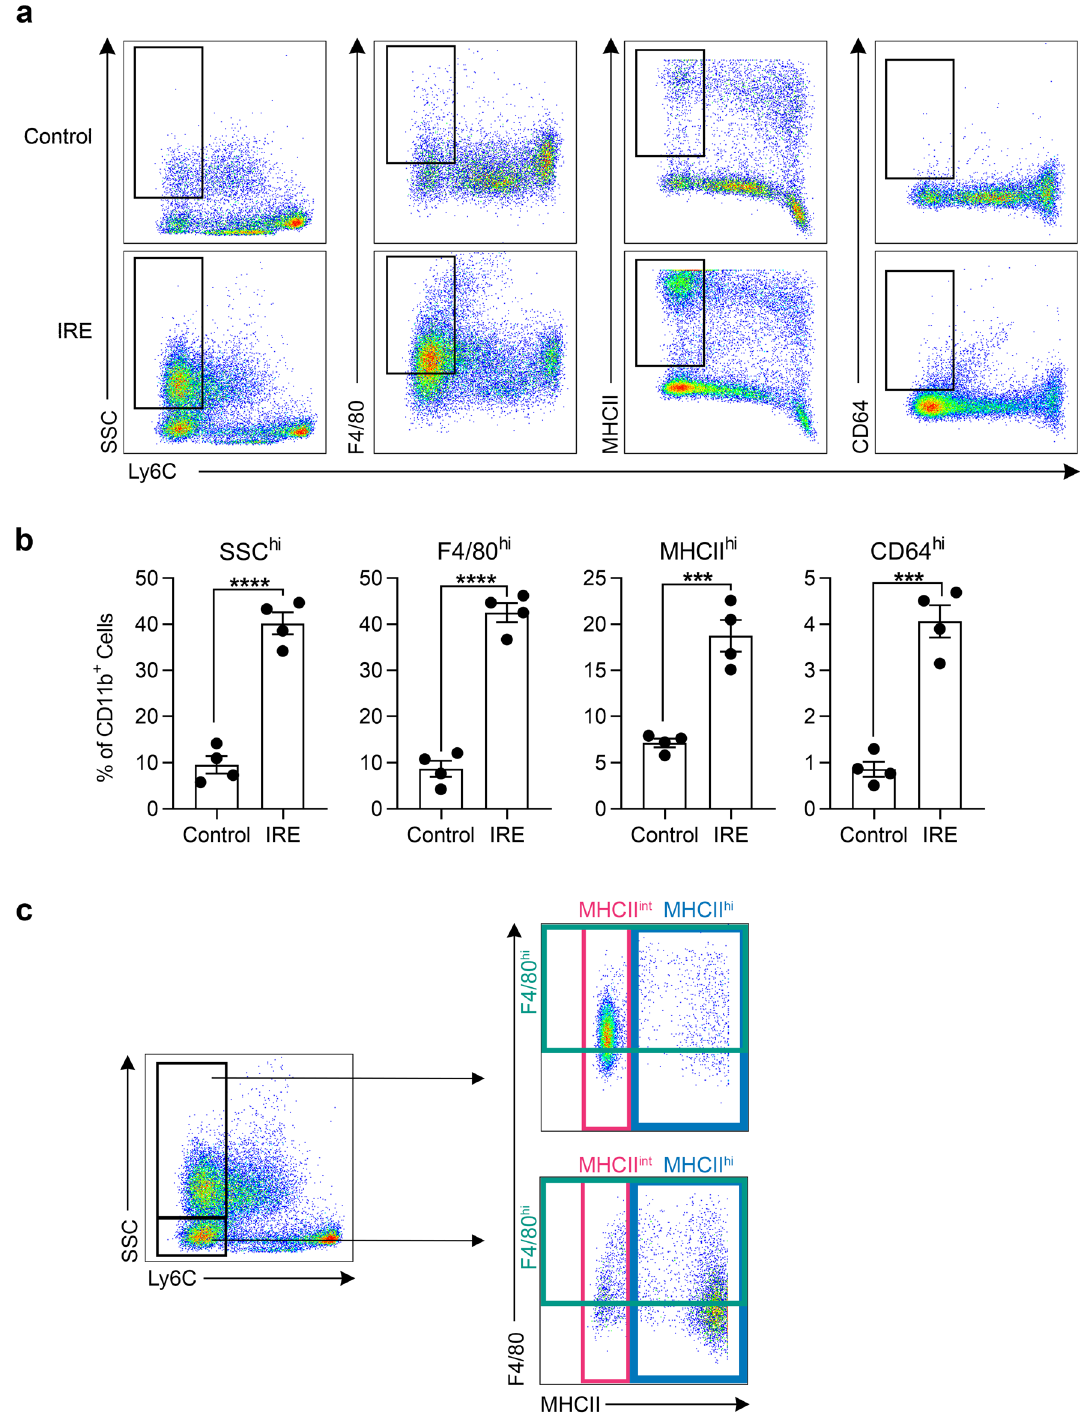
Figure 4. The majority of CD11b + Ly6C lo cells that develop in the liver after IRE treatment are side-scatter high, and express high levels of F4/80 and intermediate levels of MHCII. ( a ) Representative flow cytometry density plots showing Ly6C expression versus side-scatter (SSC), F4/80, MHCII, and CD64 of CD11b + monocytes/ macrophages isolated from the IRE-treated liver lobe compared to parts of the liver not directly treated by IRE (control) from the same animal. Rectangular gates define Ly6C lo cells that are “high” for the given marker. ( b ) Quantification of CD11b + Ly6C lo cells that are SSC, F4/80, MHCII, or CD64 high, as defined by the gates in ( a ), in control and IRE-treated parts of the liver. Two-tailed unpaired t tests show *** p < 0.001 and **** p < 0.0001. Individual points represent data from separate animals (n = 4). Graph bars and error bars show mean ± SEM. ( c ) Representative flow cytometry density plots showing that the majority (70%) of CD11b + Ly6C lo cells in IRE- treated liver are SSC hi , and that this subset is also F4/80 hi and MHCII int . The remainder of the CD11b + Ly6C lo cells that are SSC lo (30%) express lower levels of F4/80 and very high levels of